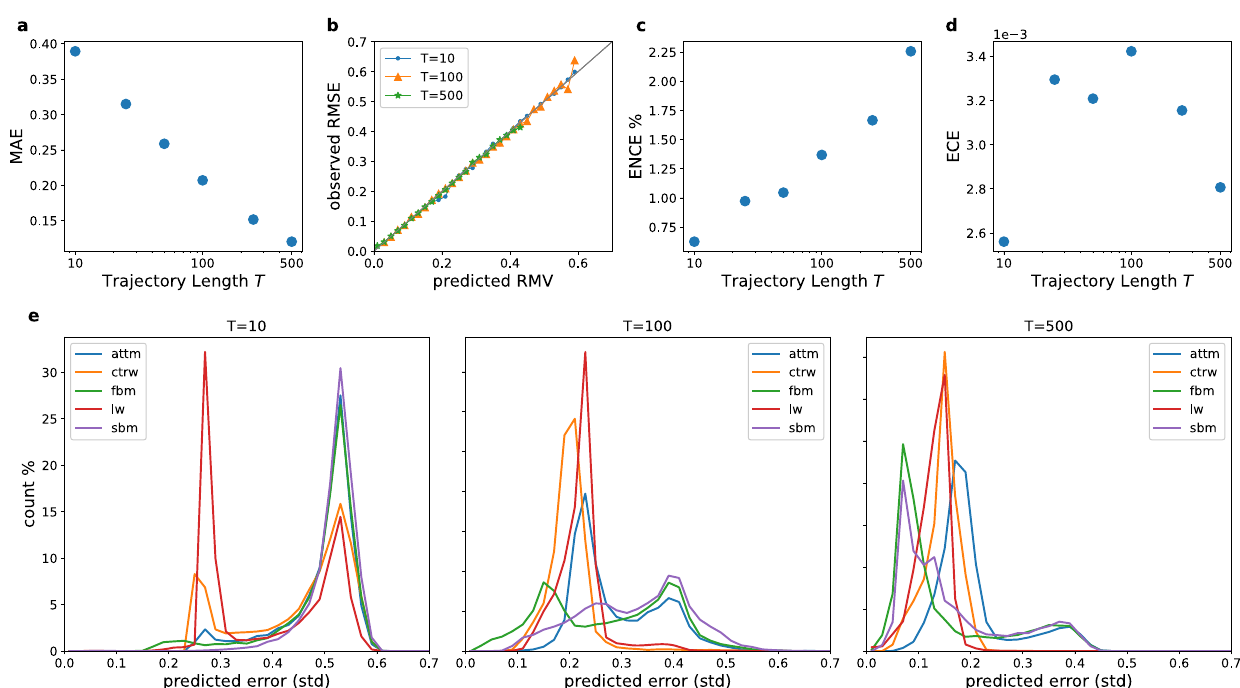
Fig. 3 | Performance evaluation for the regression of the anomalous exponent α . a Mean absolute error (MAE), b reliability diagram and expected ( c ) normalised and ( d ) non-normalised calibration error (ENCE/ECE) 82 achieved by Multi-SWAG (see Supplementary Information for detailed de fi nitions). Results are plotted for differenttrajectorylengths T byaveragingover10 5 testtrajectorieseach.TheMAEs ( a ) show a decreasing trend with trajectory length, with results close to those achieved in the AnDi-Challenge , reaching an MAE of 0.14 for T =500. To judge the errorpredictionperformance,thereliabilitydiagram( b )depictstheobservedroot mean squared error (RMSE) as a function of the predicted root mean variance (RMV),showingthatevenforveryshorttrajectories T =10anerrorpredictionclose to the ideal (grey line) is achieved. The reliability diagram can be summarised in a single value using the ECE/ENCE. The ENCE/ECE characterises the mean difference